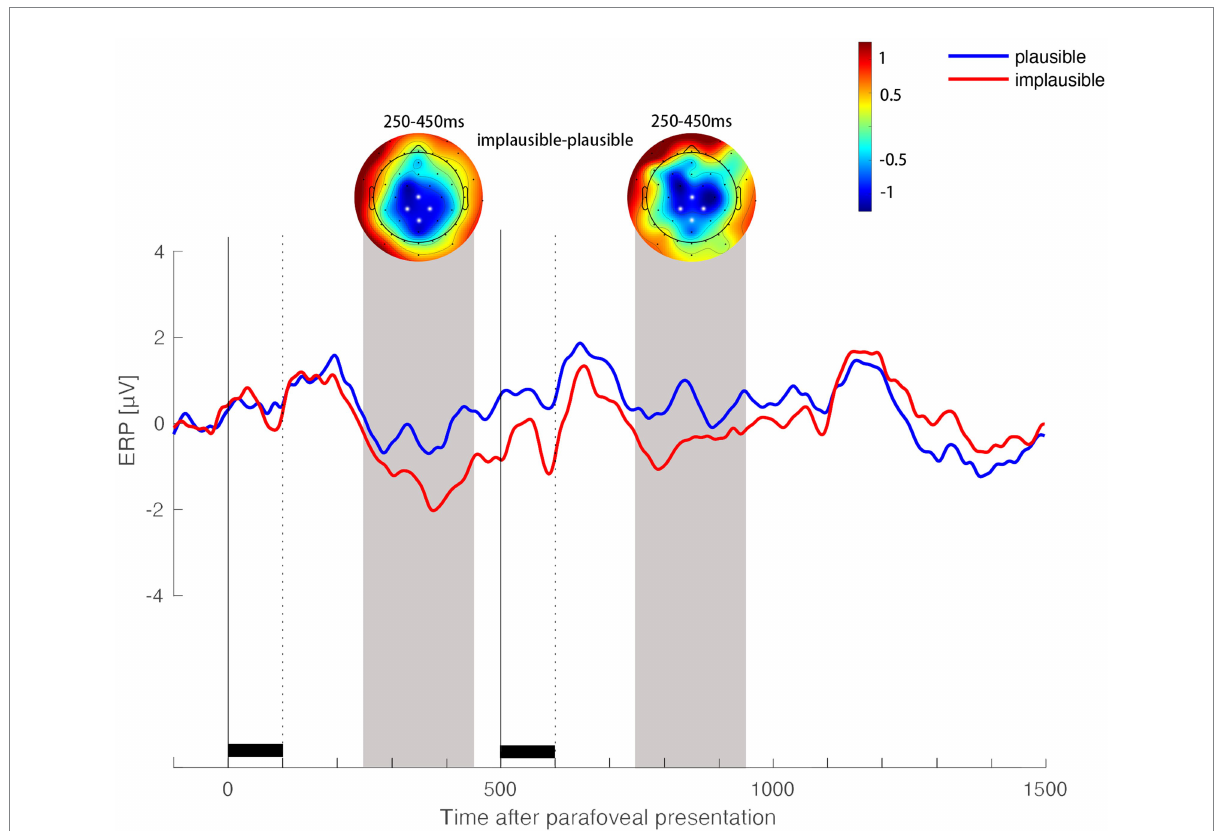
FIGURE 6 ERP plausibility effects when the target word appeared in the parafovea and subsequently again in the fovea. ERP waveforms show the average activity in the ROI of four centroparietal electrodes (highlighted in white in the topographic map) for the plausible context & identical preview condition and implausible context & identical preview condition. Scalp topographic maps show the difference in ERP activity (plausible context & identical preview minus implausible context & identical preview) in the time window of 250–450 ms after the onset of the word in the parafoveal and in the foveal position,